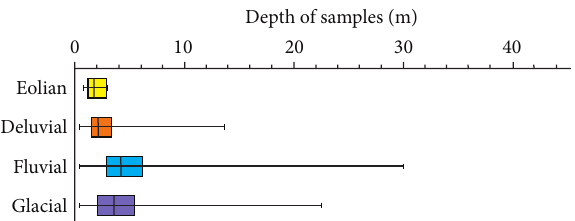
Figure 7: Depth of deposition (depth of samples) of the individual genetic types of foundation